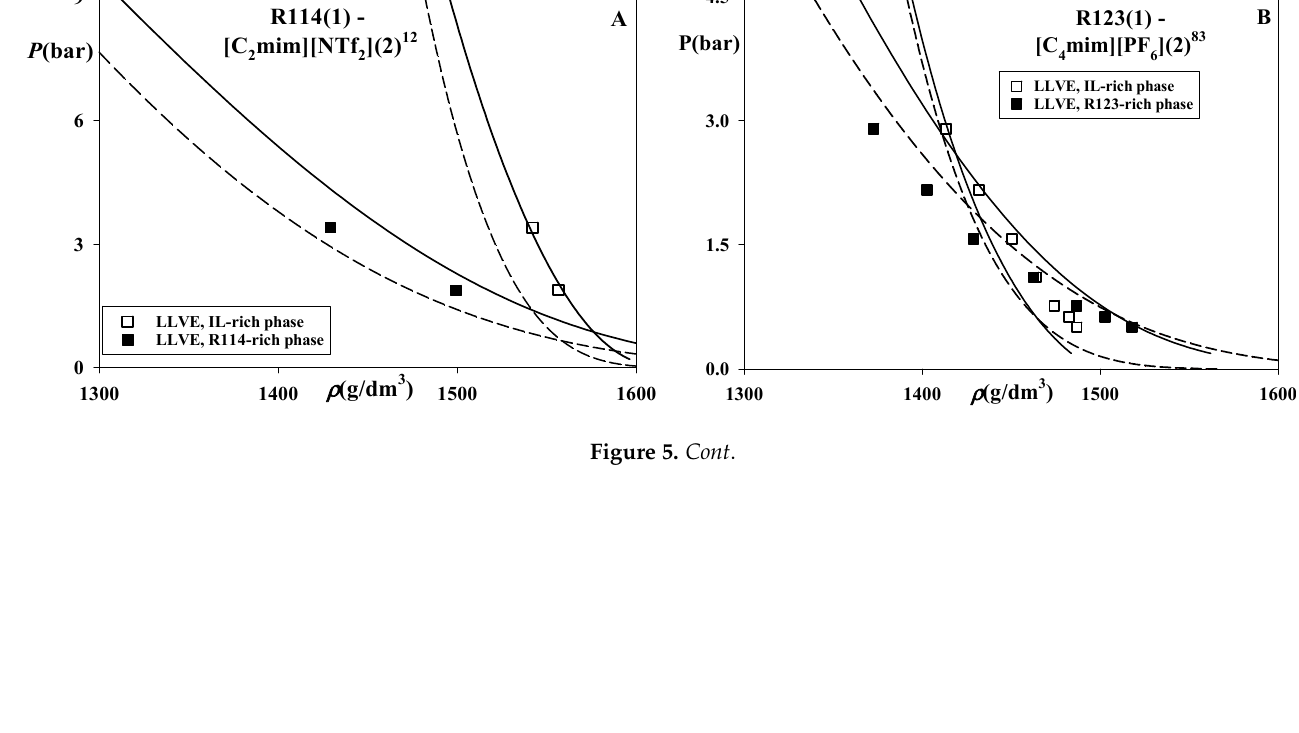
F Figure 5. Densities of saturated liquid phases along LLVE in the systems of R114, R123, R124, R134a dissolved in [C 2 mim][NTf 2 ] and [C 4 mim][PF 6 ]. Points — experimental data [11,12,75,83]. Solid lines — predictions of CP-PC-SAFT, dashed lines — predictions of SAFT-VR-Mie. k 12 = 0 for both models.